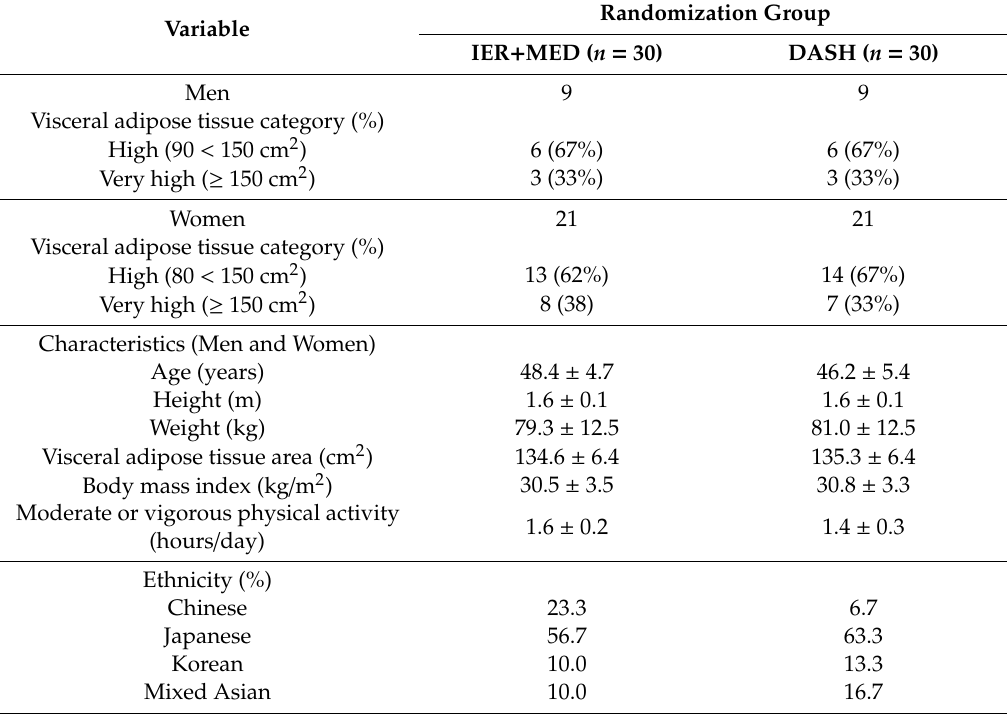
Table 1. Randomization and baseline characteristics of study participants by the intermittent energy restrictioncombinedwithaMediterraneandiet(IER + MED)anddietaryapproachestostophypertension (DASH)